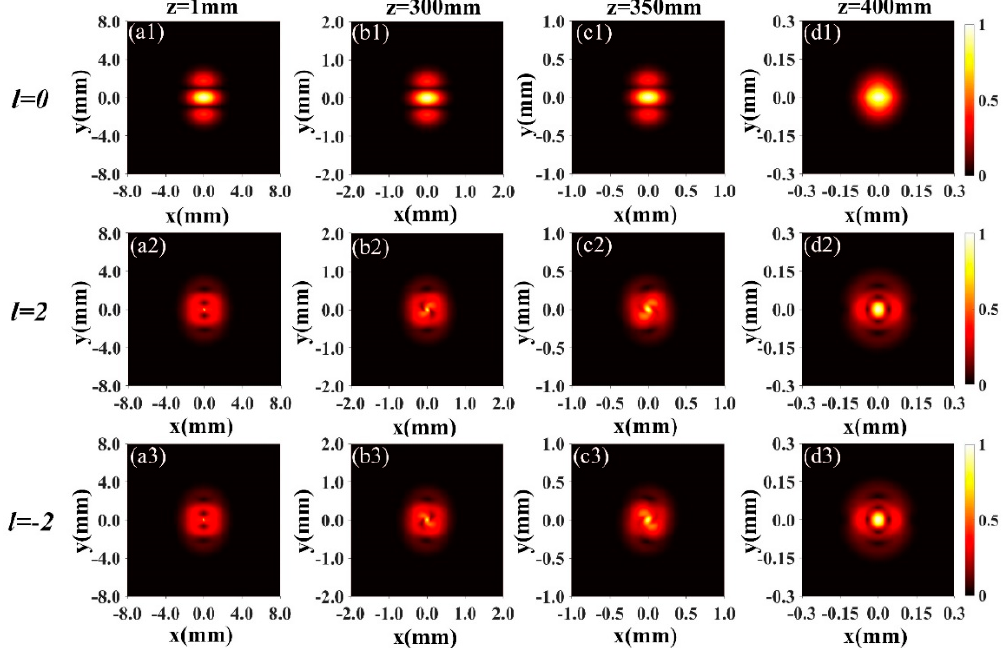
( ) Figure 5. The modulus of the DOC ( | µ ( ρ ,0; z ) | ) of a focused HGCSMLG 0l beam at different distances ,0; z μ ρ ) of a focused HGCSMLG 0l beam at different distances Figure 5. The modulus of the DOC ( with m = 0, n = 1 and increasing values of the with 0 m = , 1 n = and increasing values of the TC.